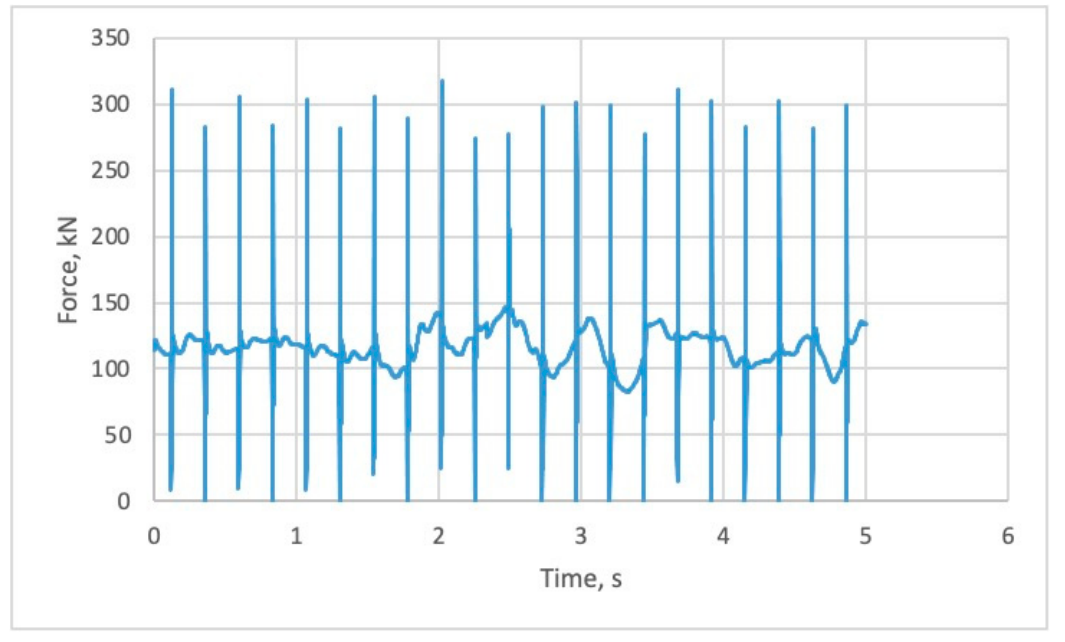
Figure 12. Calculated force values of the 87th wheelset.